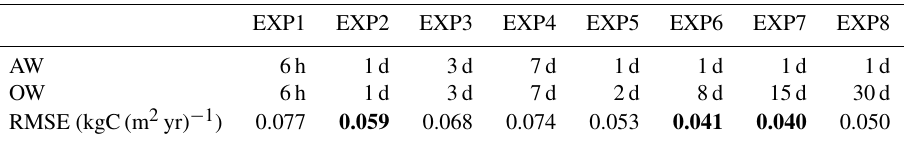
Table 1. Lengths of assimilation windows (AWs) and observation window (OWs) and the resulting time-averaged global mean RMSEs for different experiments. The first four experiments use a regular 4-D LETKF, with AW = OW. The last four experiments use AW = 1d, found to be optimal, and different